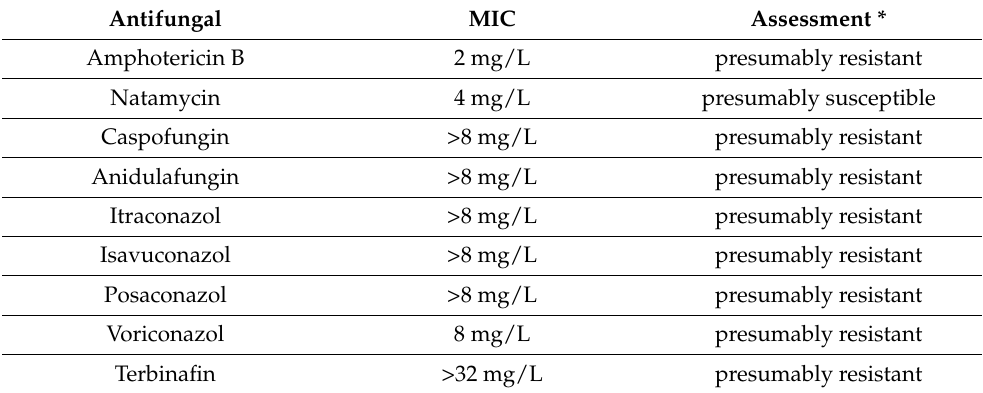
Table 1. Antifungal susceptibility testing results for F. tonkinense NRZ-2021-193.